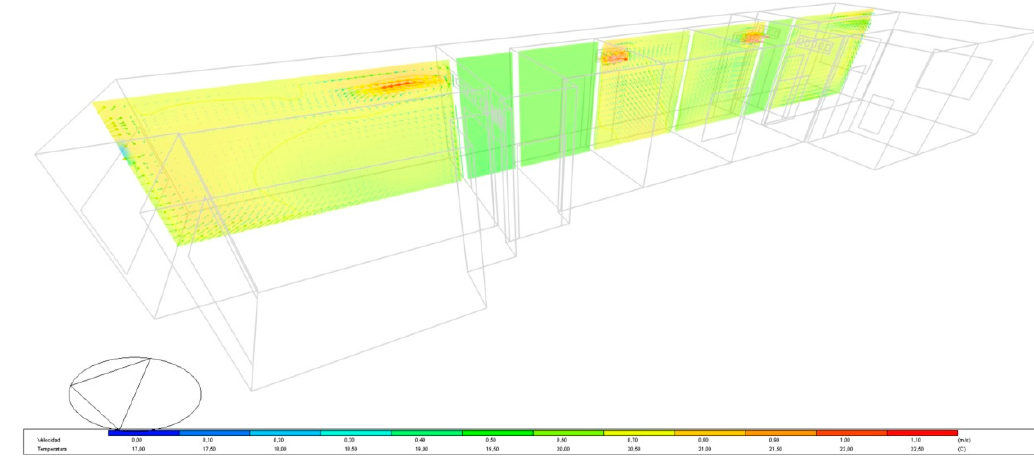
Figure 24. The all-air system with air conditioning and an air drive (convective); 1 February 2015, 9:00 a.m.